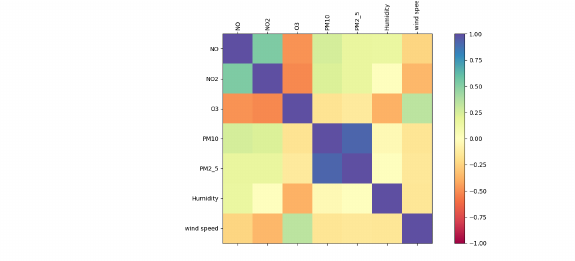
Figure 12: Correlation output between meteorological and pollu- tion parameters.